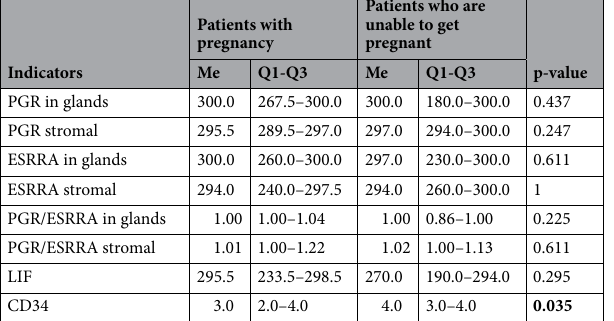
Table 4. Expression of estrogen (ESRRA) and progesterone (PGR) receptors and their ratios, leukemia- inhibiting factor (LIF) and CD34 in the endometrium of patients with pregnancy and patients who are unable to get pregnant. Significant values are in